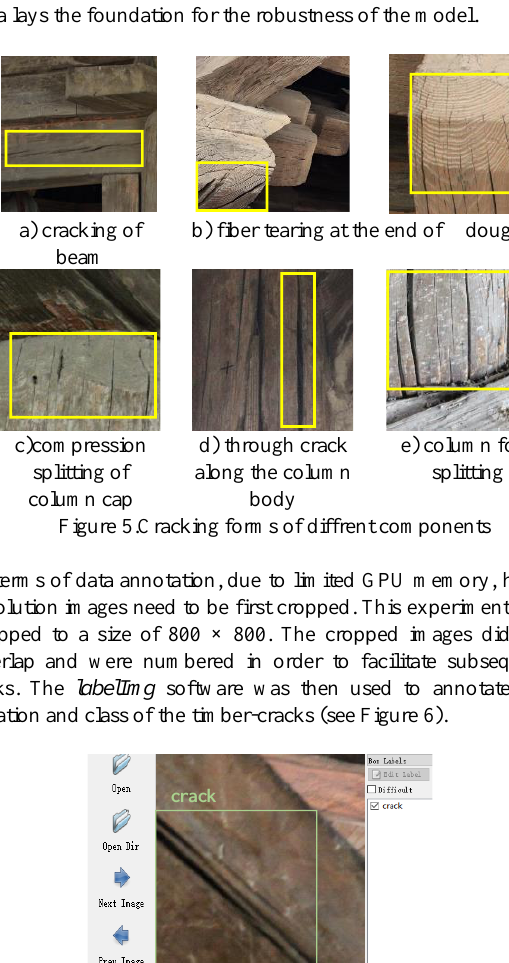
Figure 6. Data annotation